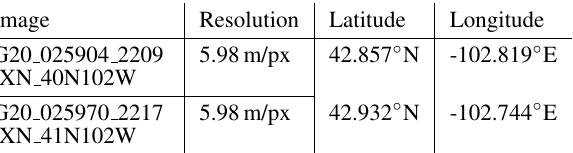
Table 1. General information about the